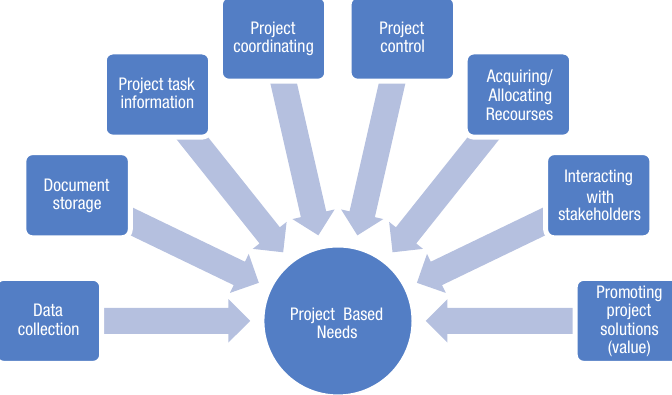
Fig. 1. Typology of project-based needs (adapted by authors from Johannessen, Olsen